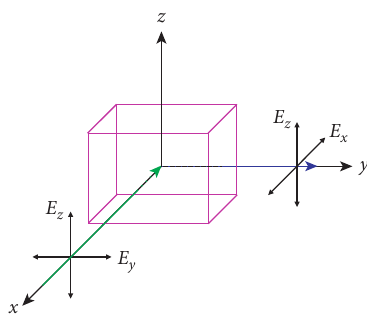
Figure 3: The experimental optical path for measuring the hyper- Raman depolarization